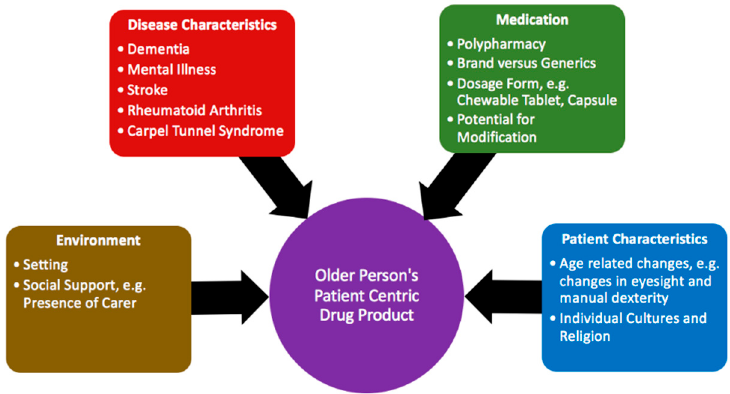
Figure 3. A holistic approach towards the design of an older person’s patient-centric drug product—four key areas have an impact on preferences for formulation characteristics.